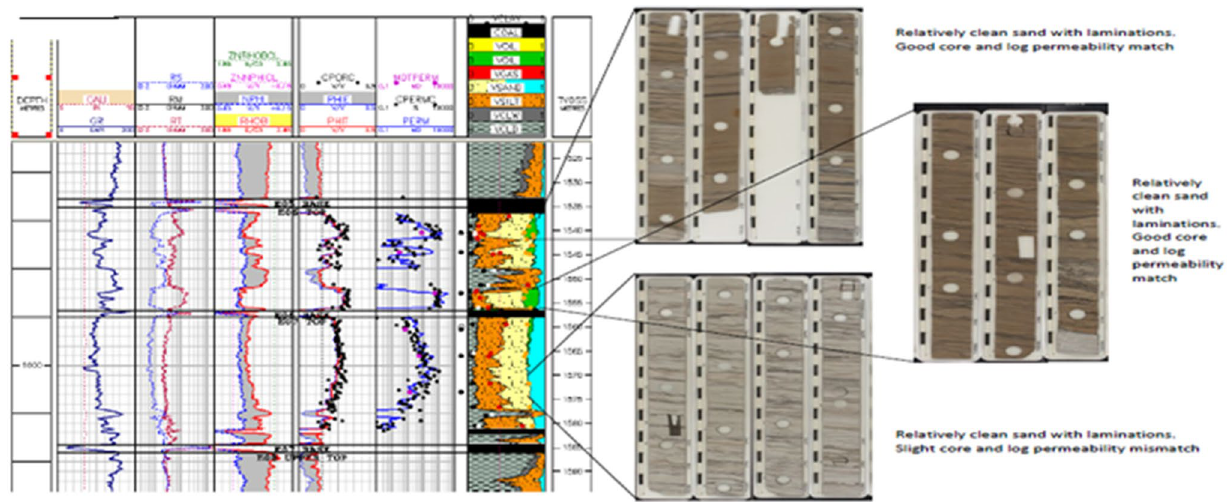
Fig. 3 Final log interpretation using SSC model calibrated by sieve analysis and XRD for lithology